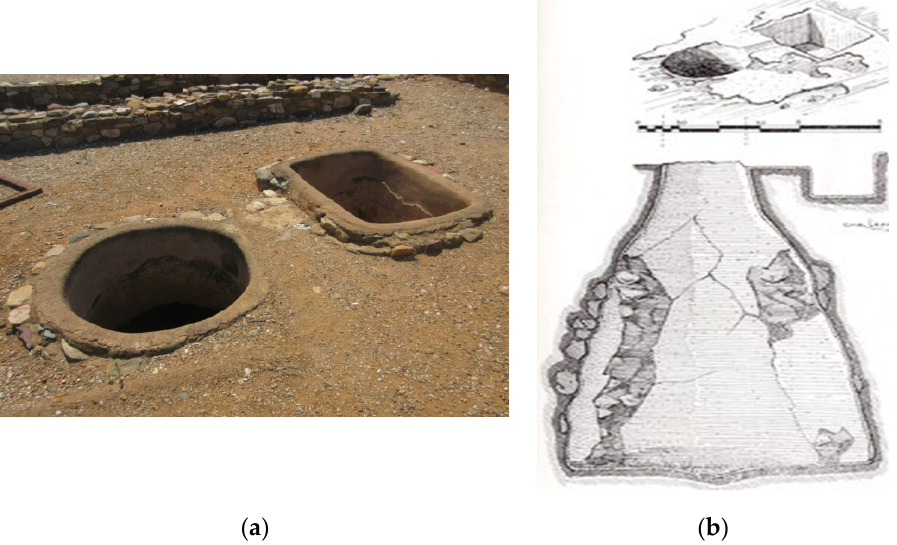
Figure 3. Olynthus bottle-shaped cistern with a small tank for pretreatment, including the capture of debris and sediment: ( a ) plan and ( b ) cross section [22].